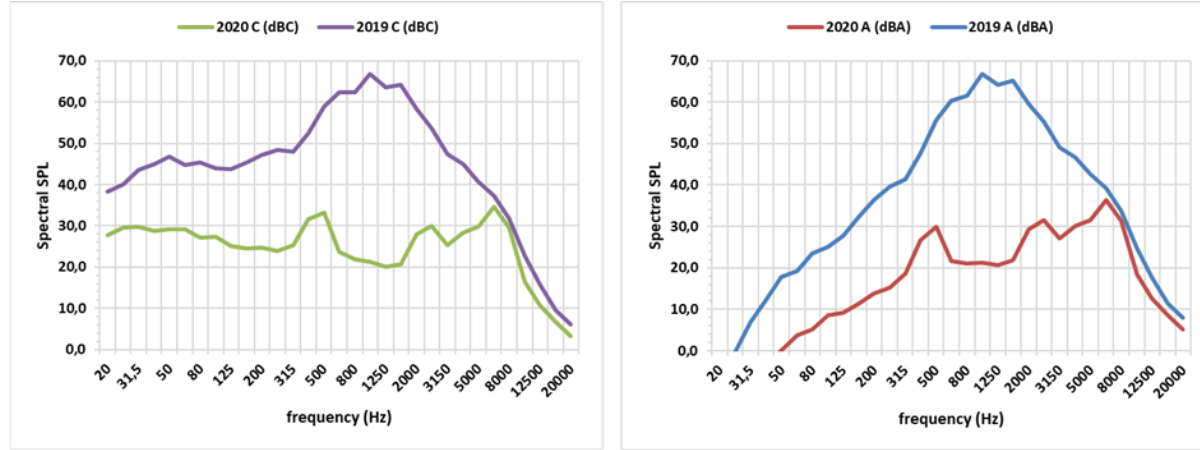
Figure 6: Overall C and A-weighted sound spectrum in 2019 vs 2020 at site no. 1 (CAR)